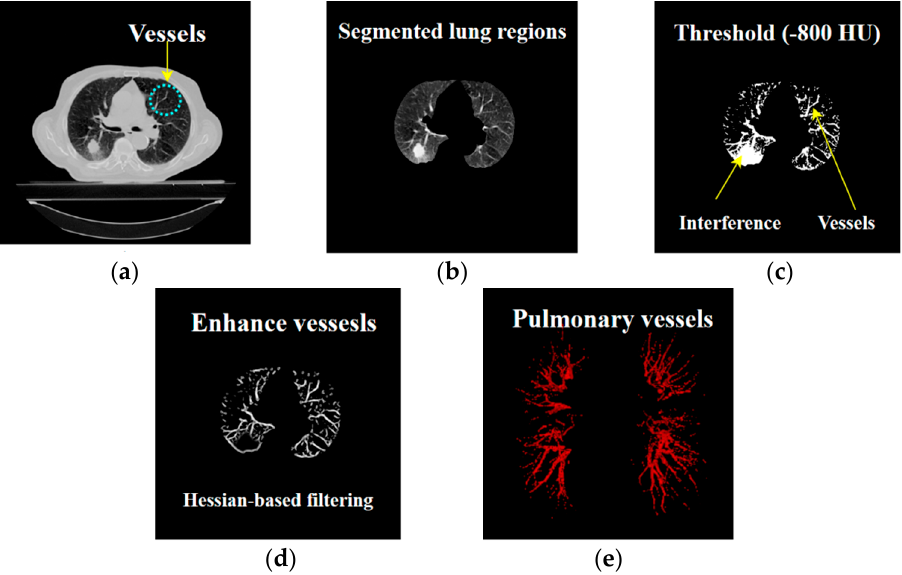
Figure 6. Segmentation of the pulmonary vessels: ( a ) input 2D CT slice, ( b ) segments of lung regions; ( c ) segments of lung internal structures, ( d ) enhanced vessels using multiscale vessel enhancement filtering, ( e ) isotropic structure of the segmented pulmonary vessels.